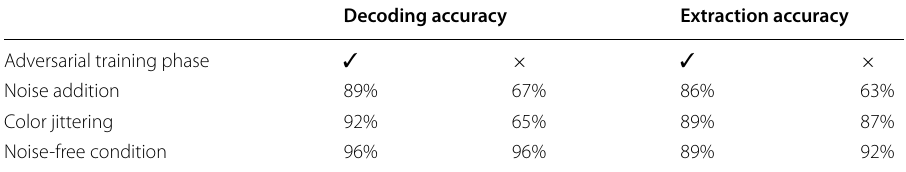
Table 7 Ablation study for adversarial training